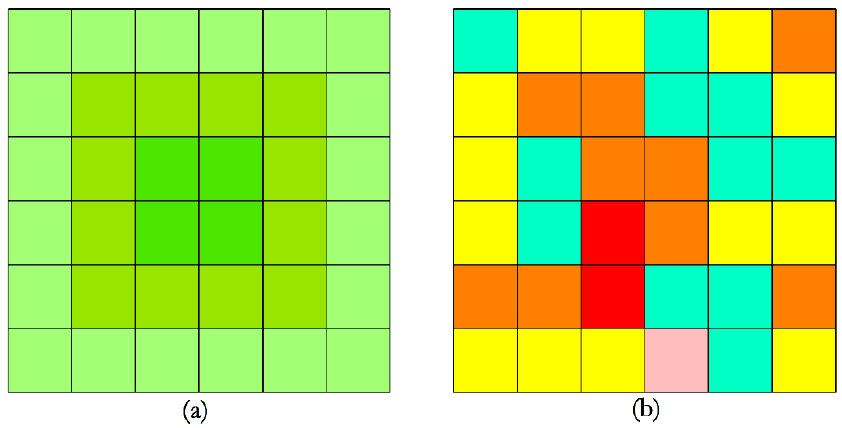
Figure 3. Two different objects in the image: ( a ) object A with small internal variation and ( b ) object B with large internal variation (the difference in pixel color represents the difference between the features of the pixels).